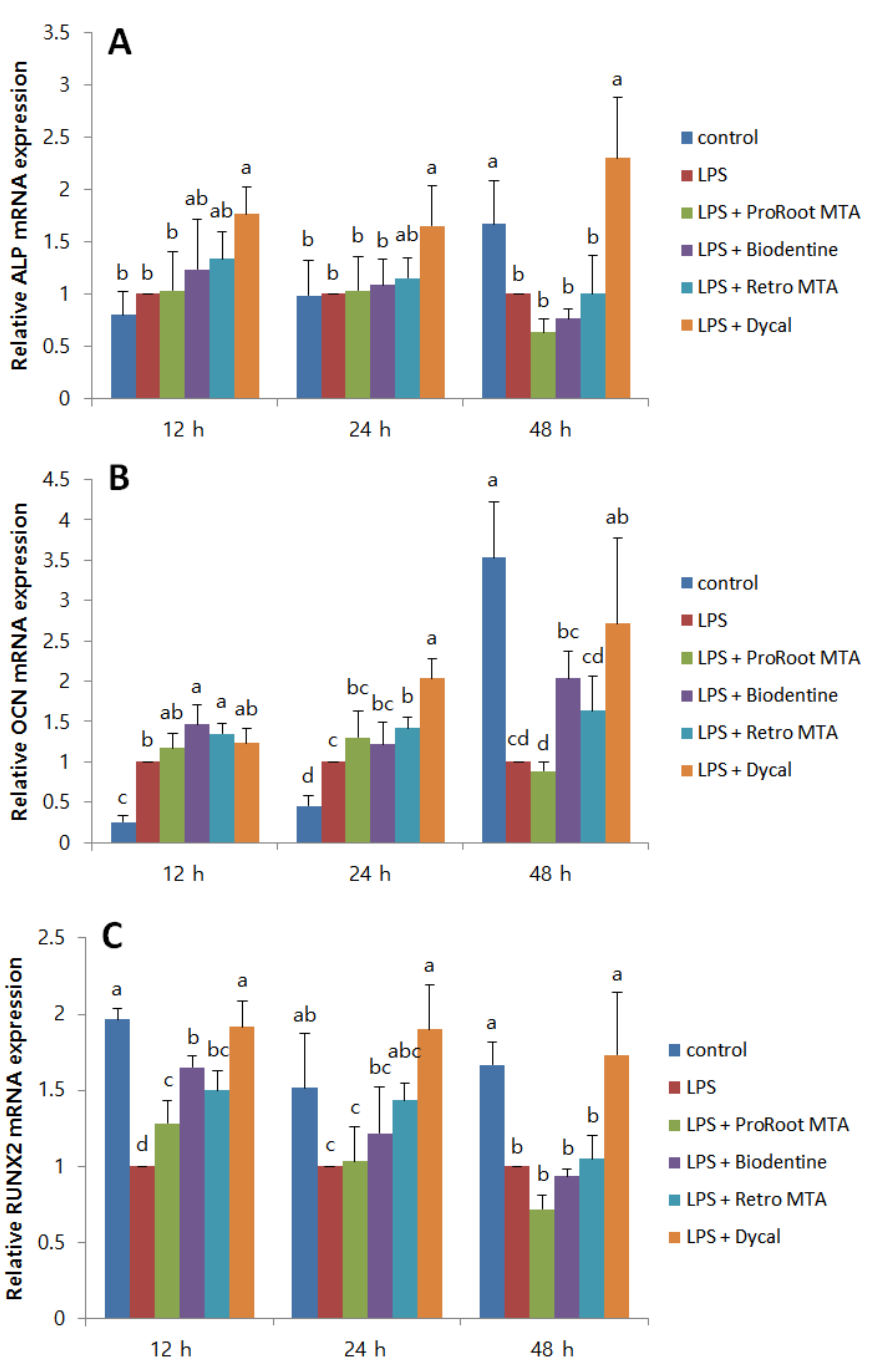
Figure 3. The effects of CSCs on the ALP, OCN, and RUNX2 expressions of LDPSCs. Relative ( A ) ALP ( B ) OCN, and ( C ) RUNX2 expressions were measured using quantitative real-time polymerase chain reaction (qPCR) and normalized using β-actin. ( A ) ALP: a > b ( p < 0.05), ( B ) OCN: a > b, c, d; b > c, d; c > d ( p < 0.05), ( C ) RUNX2: a > b, c, d; b > c, d; c > d ( p < 0.05), different alphabet letters represent statistically significant differences between the materials within the same time group. Control, hDPSCs cultured with normal medium; LPS, LDPSCs cultured with normal medium; LPS + ProRoot MTA, LDPSCs cultured with ProRoot MTA extract medium; LPS + Biodentine, LDPSCs cultured with Biodentine extract medium; LPS + Retro MTA, LDPSCs cultured with Retro MTA extract medium; LPS + Dycal, LDPSCs cultured with Dycal extract medium.